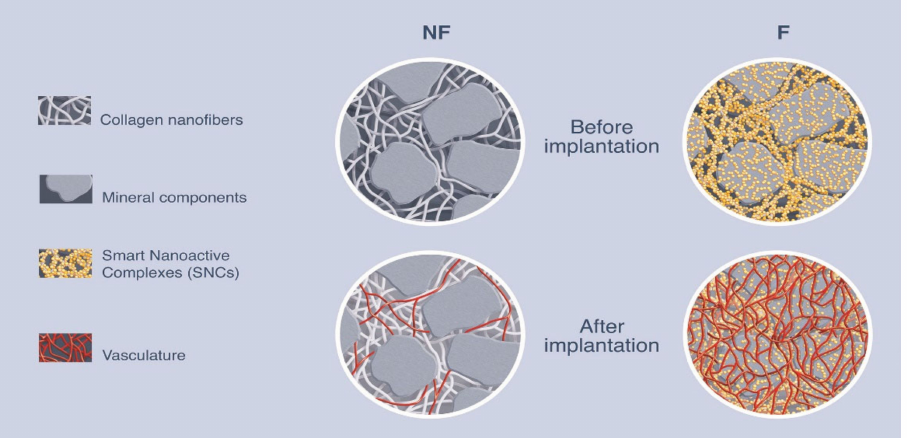
Figure 6. Mechanistic illustration of vascularized new generation of hybrid bone